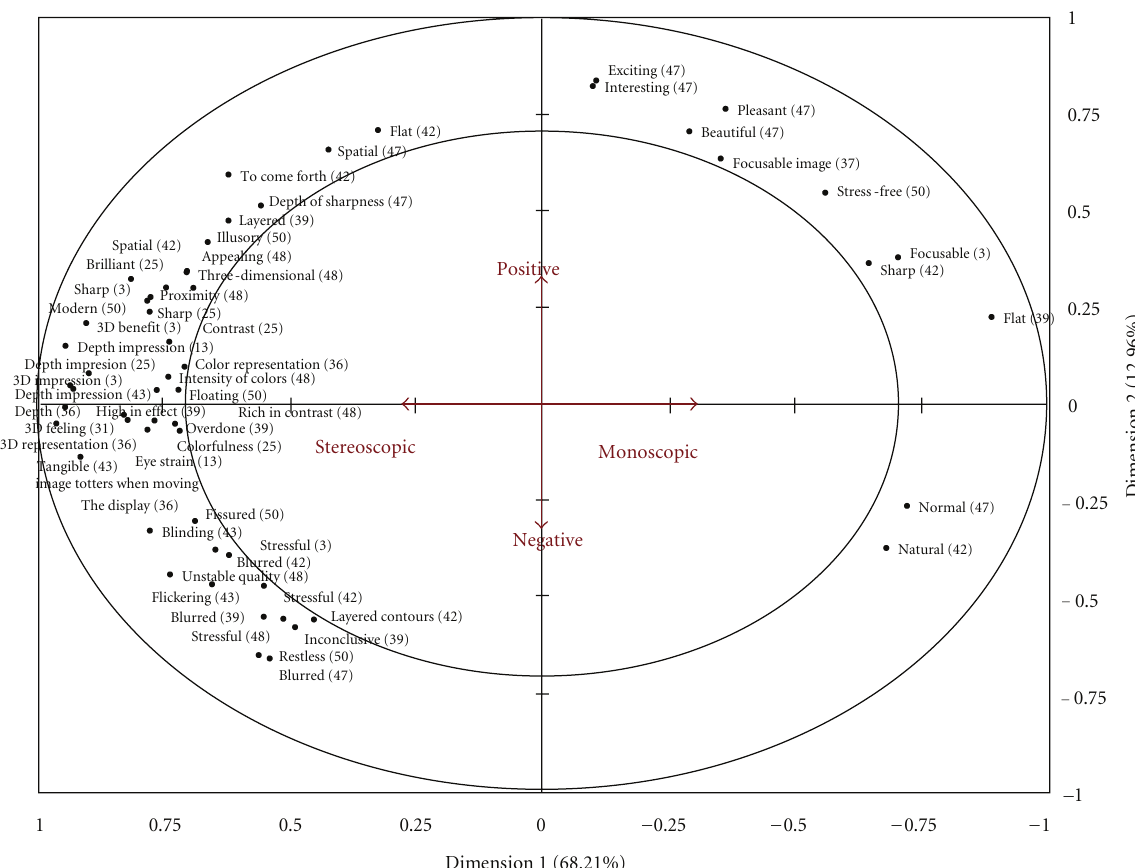
Figure 11: PCA correlation loadings with attributes in the space of PC1 and